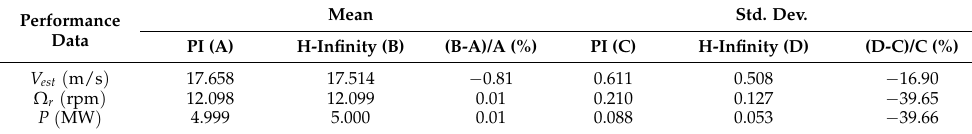
Table 7. Comparison of EOG results for performance data in 18 m/s noiseless